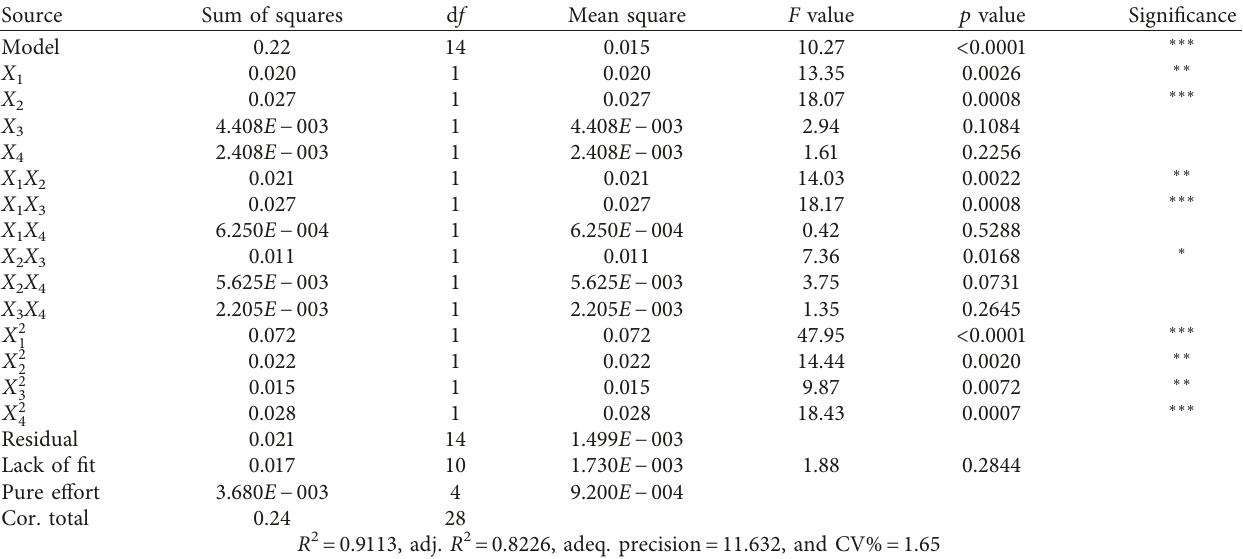
Table 4: ANOVA of the predicted regression model for